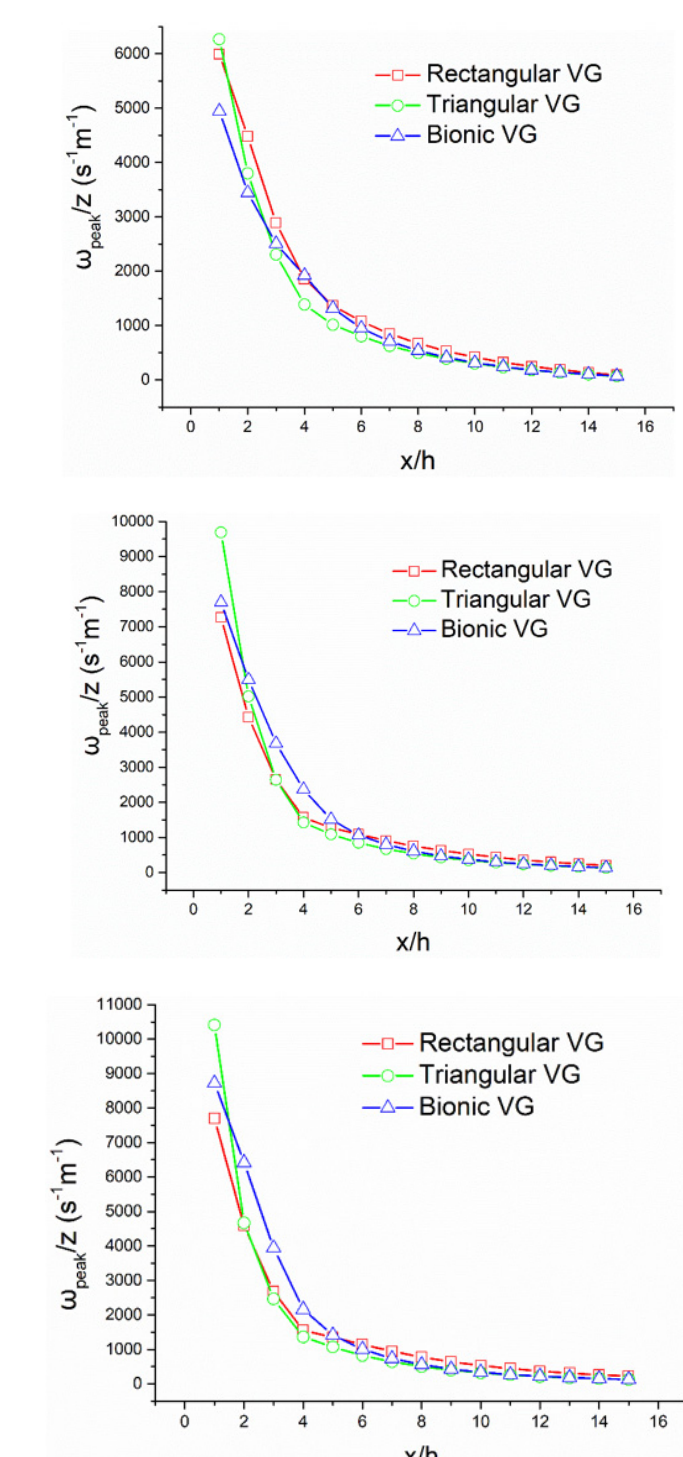
Figure 7. Variation of the reconciliation strength factor on different testing surfaces.